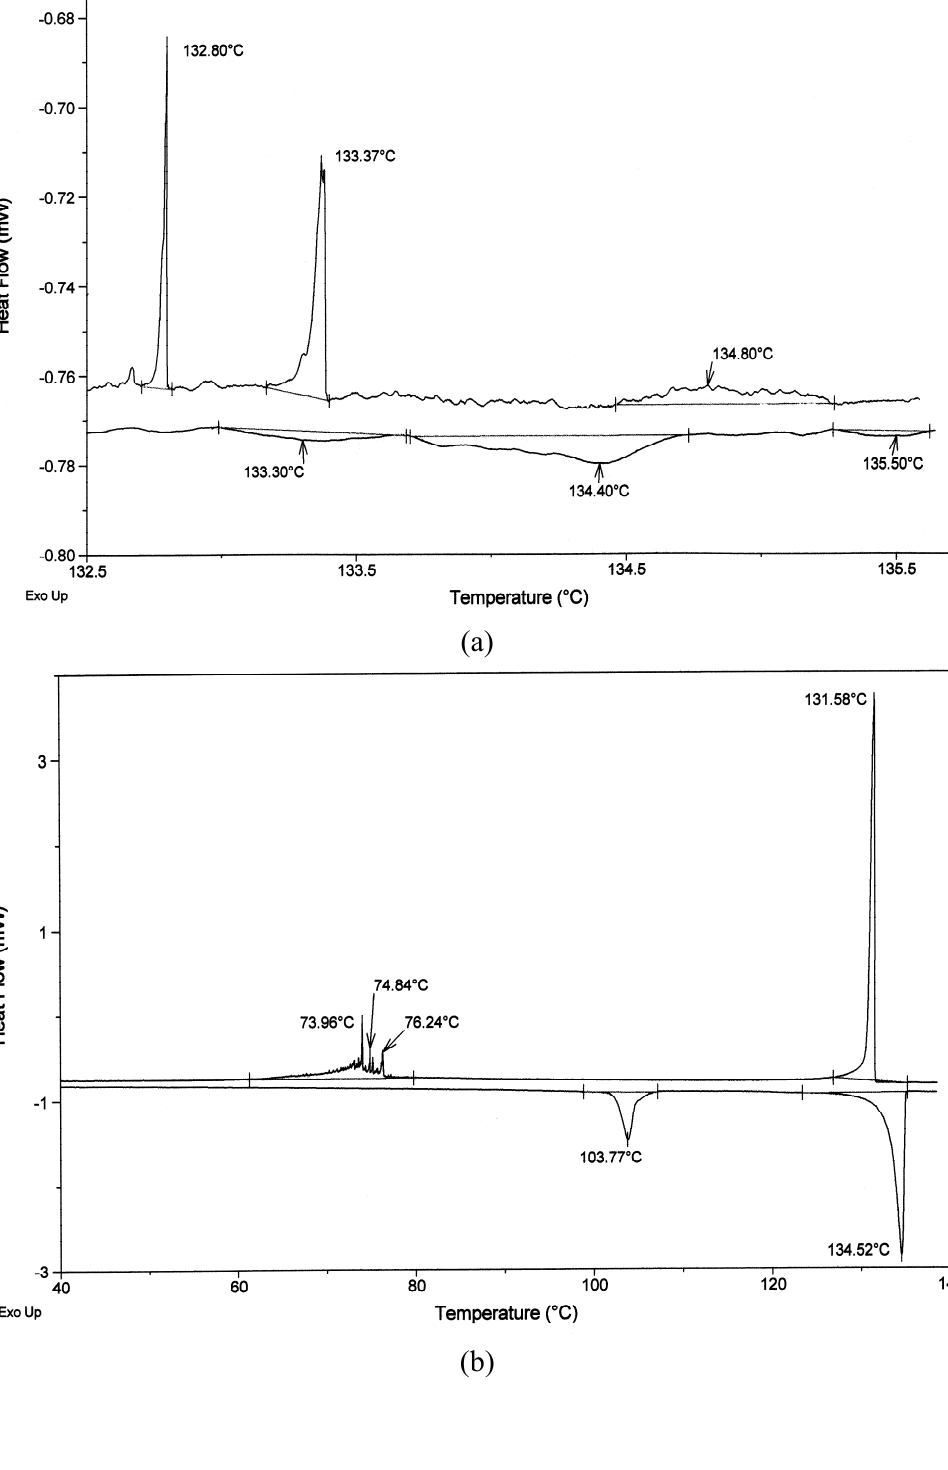
Figure 6. (a) The DSC traces of symmetrical azomethine AT1 at a h/c rate of 0.01 ° C/min and (b) The DSC traces of symmetrical azomethine AT1 at a h/c rate of 0.35 ° C/min. (c) DSC traces of symmetrical azomethine AT2 at a h/c rate of 1 ° C/min and (d) DSC traces of symmetrical azomethine AT2 at a h/c rate of 0.4 ° C/min. (e) DSC traces of symmetrical azomethine A3 at a h/c rate of 1 °